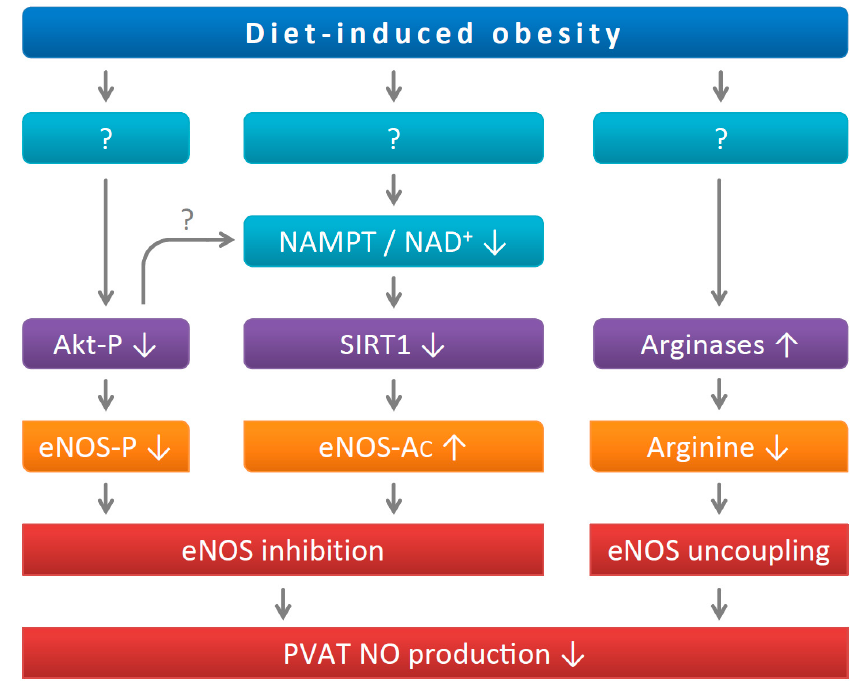
Figure 6. PVAT eNOS dysregulation in diet-induced obese mice. Diet-induced obesity leads to inhibition of Akt phosphorylation. The downregulation of NAMPT reduces cellular NAD + levels and SIRT1 activity. The resulting reduction in eNOS phosphorylation and enhancement of eNOS acetylation both decrease eNOS activity. In addition, HFD feeding causes eNOS uncoupling due to arginine deficiency because of arginase induction. The illustrated mechanisms are a summary of results from the present study and two previous publications [7,11].